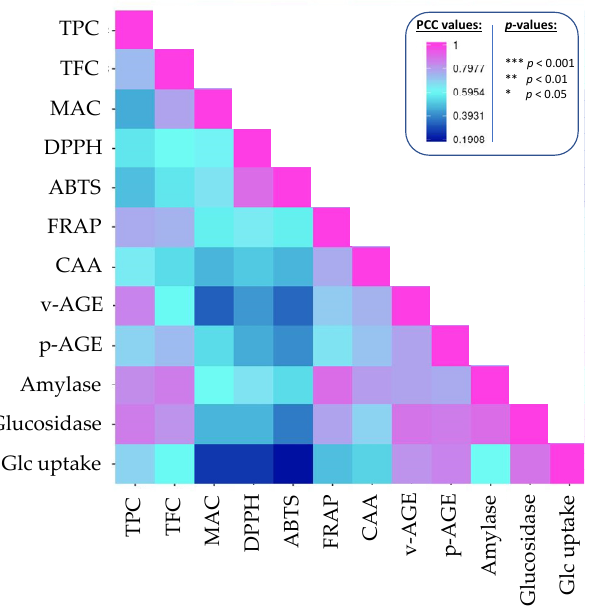
Figure 3. Correlogram analysis (Pearson coefficient correlation) between phytochemicals, antioxidant and anti-diabetic activities of extracts from beans from ten Fabaceae species subjected to traditional cooking and in vitro gastrointestinal digestion. The actual values and p -values are provided in Table S2.